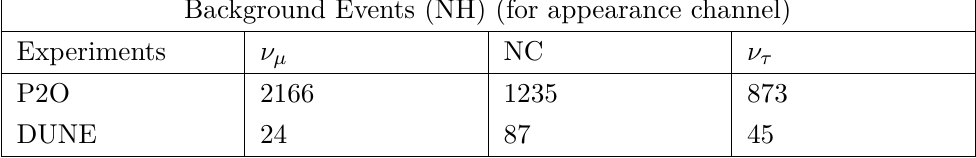
Table 4 . Total number of background events for the ν e channel for P2O and DUNE. These events corresponds to 3 years running of P2O and 3.5 year running of